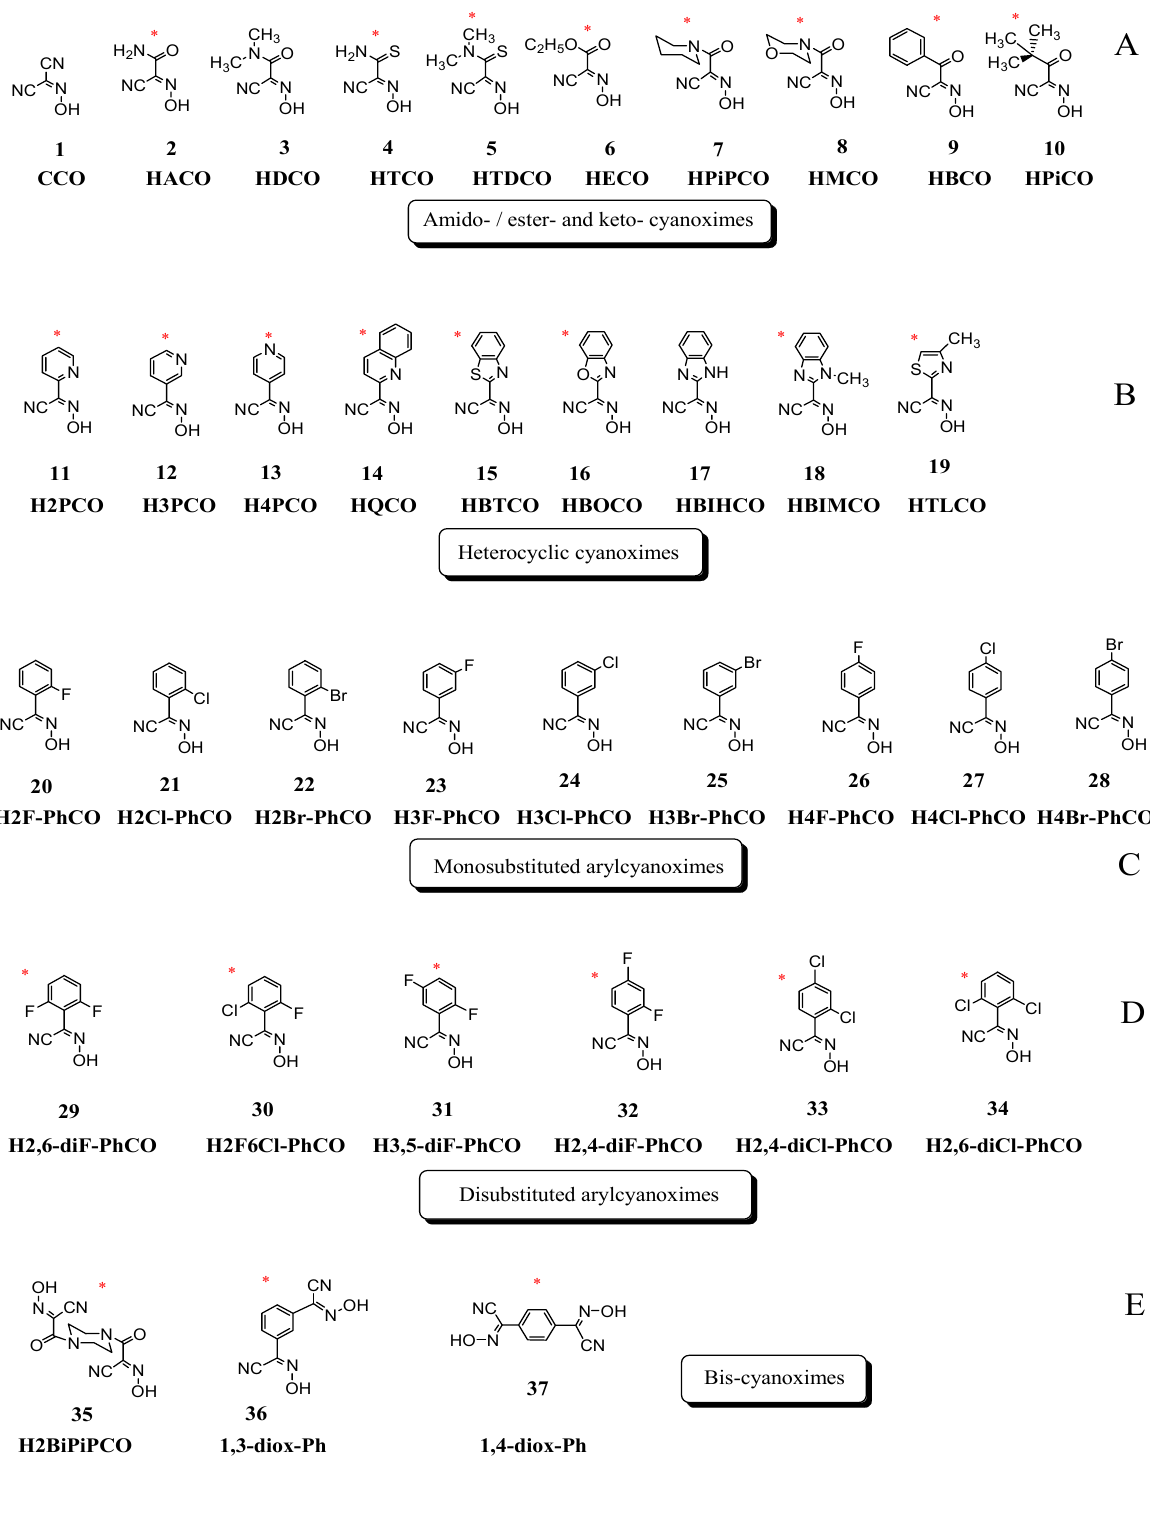
Figure 3. Currently known and studied cyanoximes. A red asterisk indicates compounds for which crystal structures were